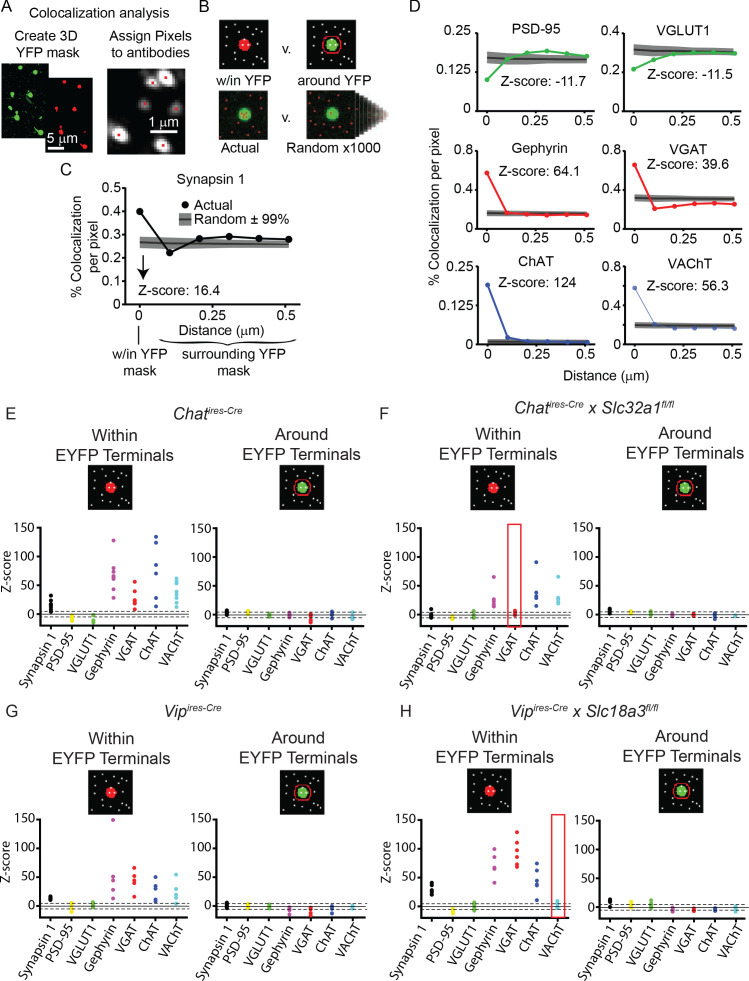
Summary antibody colocalization with VIP+/ChAT+ pre-synaptic terminals.(A–C) Illustration of antibody colocalization analysis. (A) A 3D mask is created from the YFP signal corresponding to ChAT+ presynaptic terminals, and individual pixels are assigned to each punctum of antibody signal according to the location of peak intensity of a Gaussian fit of the raw antibody fluorescence. (B) The colocalization of the binary antibody puncta and YFP masks is then determined as the percent of YFP pixels that overlap with antibody pixels, and compared both to the colocalization within expanding concentric areas around the YFP masks and to 1000 rounds of randomized antibody puncta locations. (C) Example of the colocalization of Synapsin 1 within the YFP masks compared to the region surrounding the YFP masks and to the randomized antibody locations. A z-score is taken by subtracting the random level of colocalization from the actual colocalization and dividing by the standard deviation of the randomized trials. (D) Example graphs from a single sample showing the colocalization of PSD-95, VGLUT1, Gephyrin, VGAT, ChAT, and VAChT within and around the YFP masks. (E–H) Summary z-scores of colocalizatoin both within (left panels) and around (right panels) the YFP mask across samples. Data are shown from Chatires-Cre mice (n = 8 samples from 3 mice) to show the baseline colocalization in cortical ChAT+ interneurons and from mice with VGAT deleted from cholinergic neurons (Chatires-Cre x Slc32a1fl/fl; n = 6 from 3 mice). Loss of VGAT enrichment is highlighted in red. Colocalization is also shown for cortical VIP+ interneurons from Vipires-Cre mice (n = 5 from 3 mice) and from mice with VAChT deleted from VIP+ interneurons (Vipires-Cre x Slc18a3fl/fl; n = 6 from 3 mice). Loss of VAChT enrichment is highlighted in red. Portions of this figure are duplicated from Figure 4.